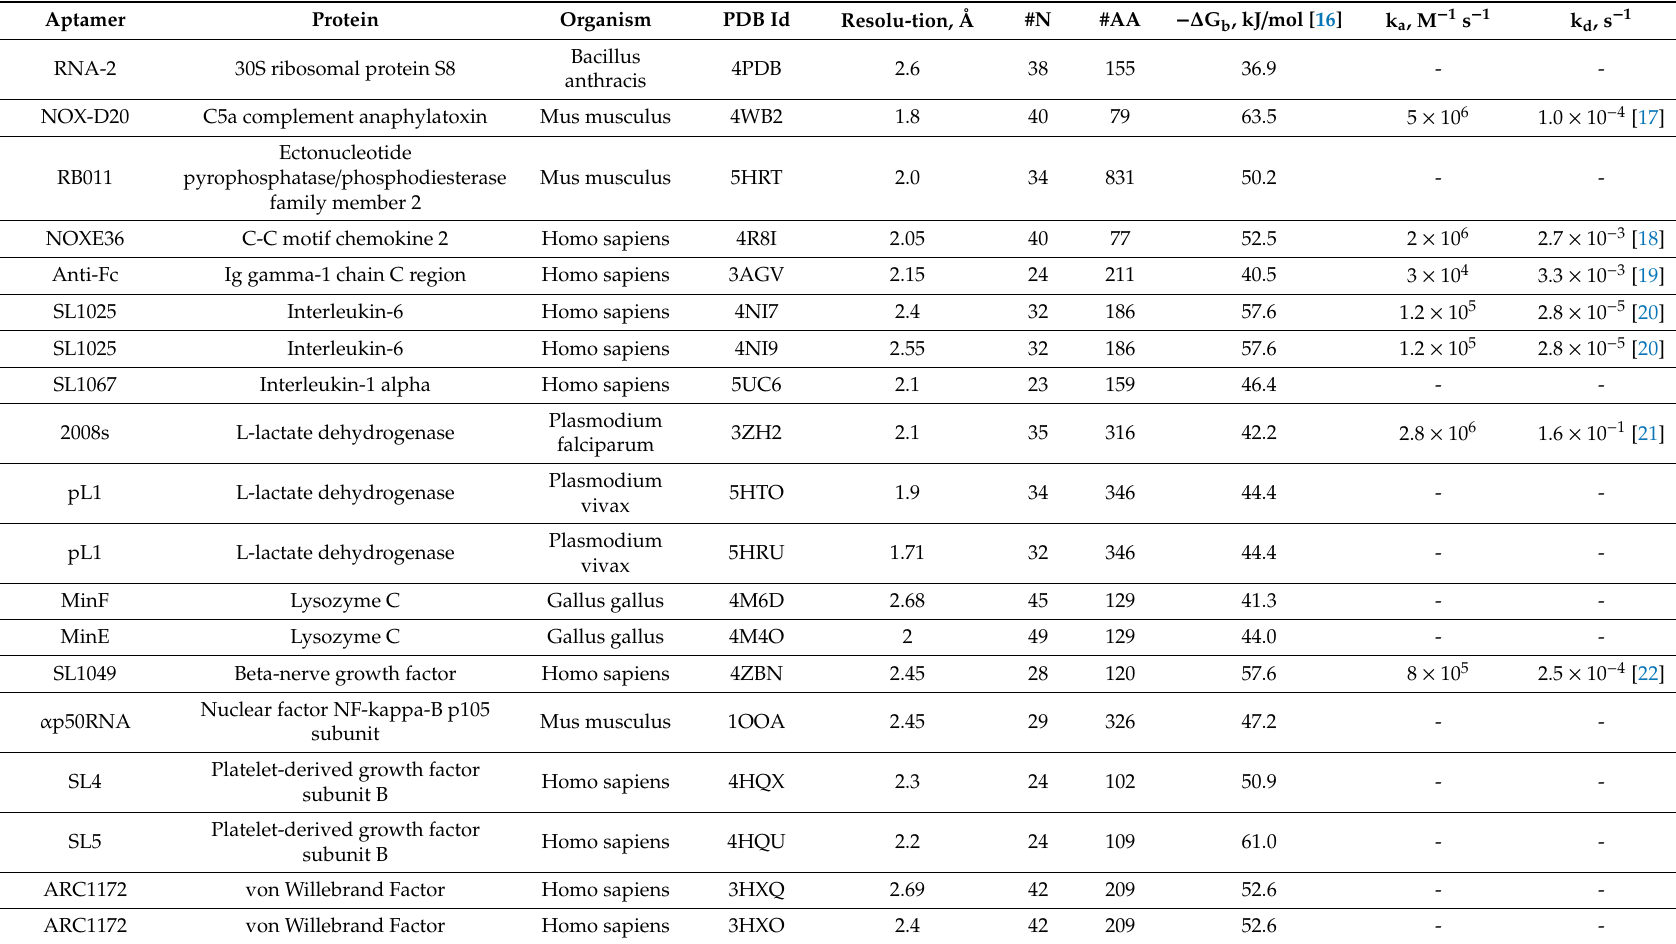
Table 1. A list of aptamer–protein complexes and their parameters, including a host organism of protein, accession number in Protein data bank (PDB Id), resolution of the structure, numbers of nucleotides (#N) and amino acid (#AA) residues, change in Gibbs free energy during binding ( ∆ G b ), kinetic constants of association (k a ), and dissociation (k d ). G-quadruplex aptamers to thrombin are shown in grey color. The values in brackets are references for kinetic